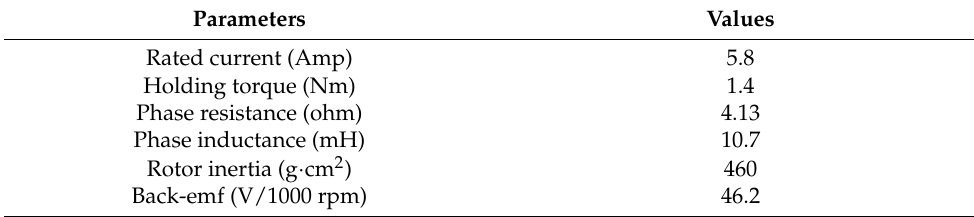
Table 2. The test motor